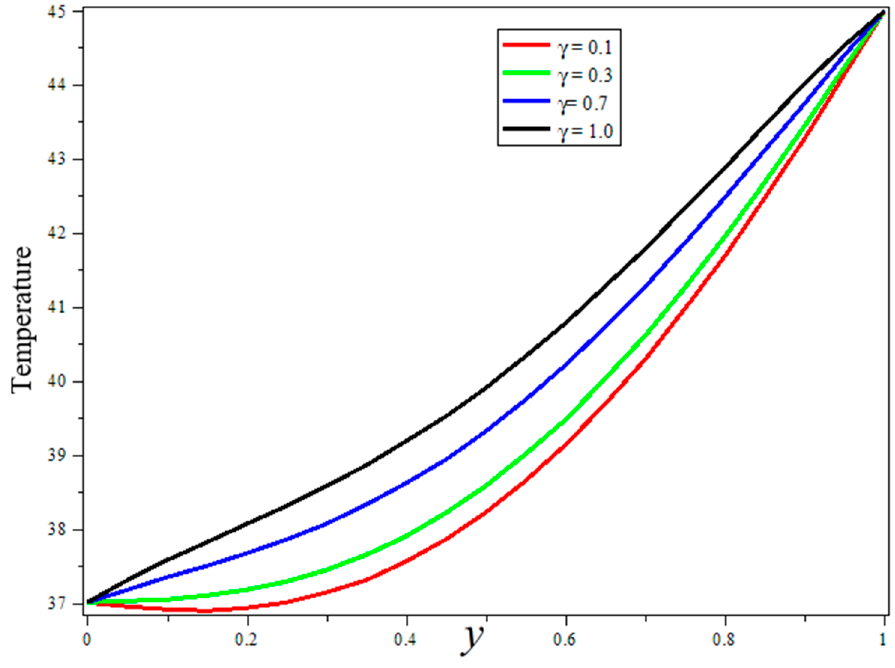
Figure 1. The influence of radiation parameters on the temperature field during tumor hyperther- mia therapy.